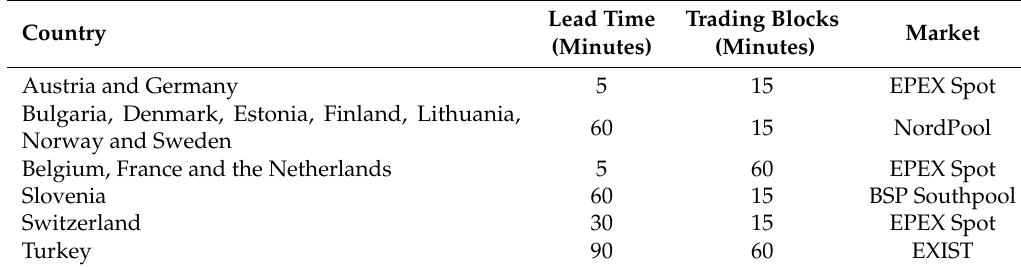
Table 3. Lead times and smallest trading blocks for different countries. Sources: Epex